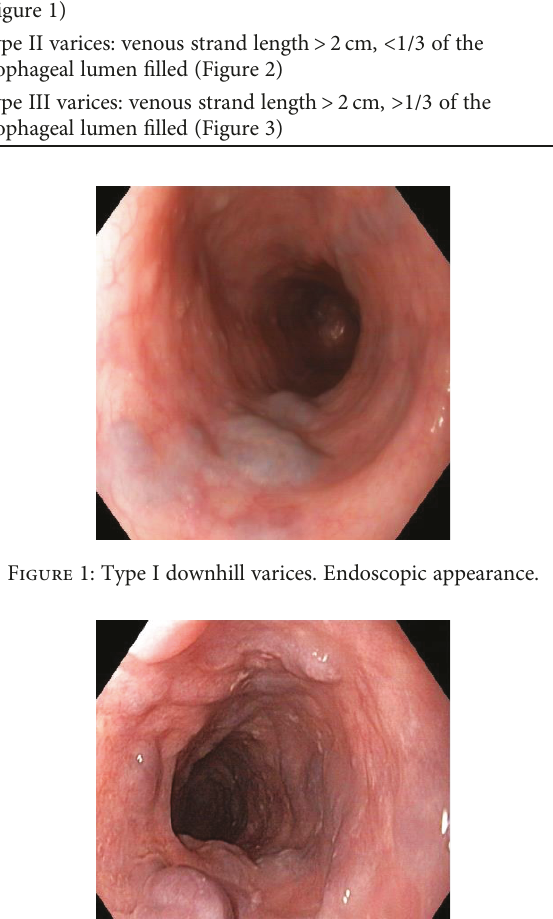
Table 1: Classi fi cation of the types of the downhill varices. Type I varices: focal venous nodes above the mucosal niveau (Figure 1) Type II varices: venous strand length > 2cm, < 1/3 of the esophageal lumen fi lled (Figure 2) Type III varices: venous strand length > 2cm, > 1/3 of the esophageal lumen fi lled (Figure 3)